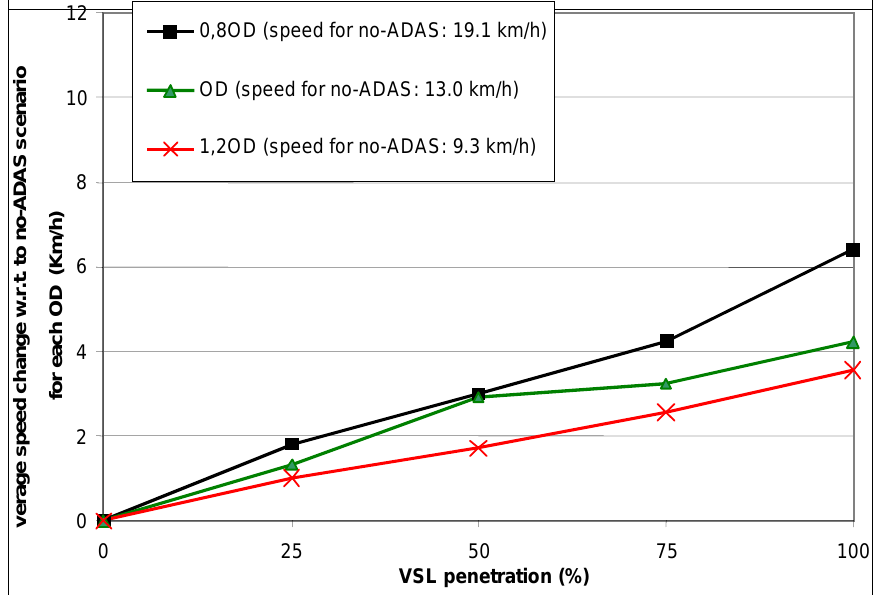
Figure 3. VSL network efficiency impacts